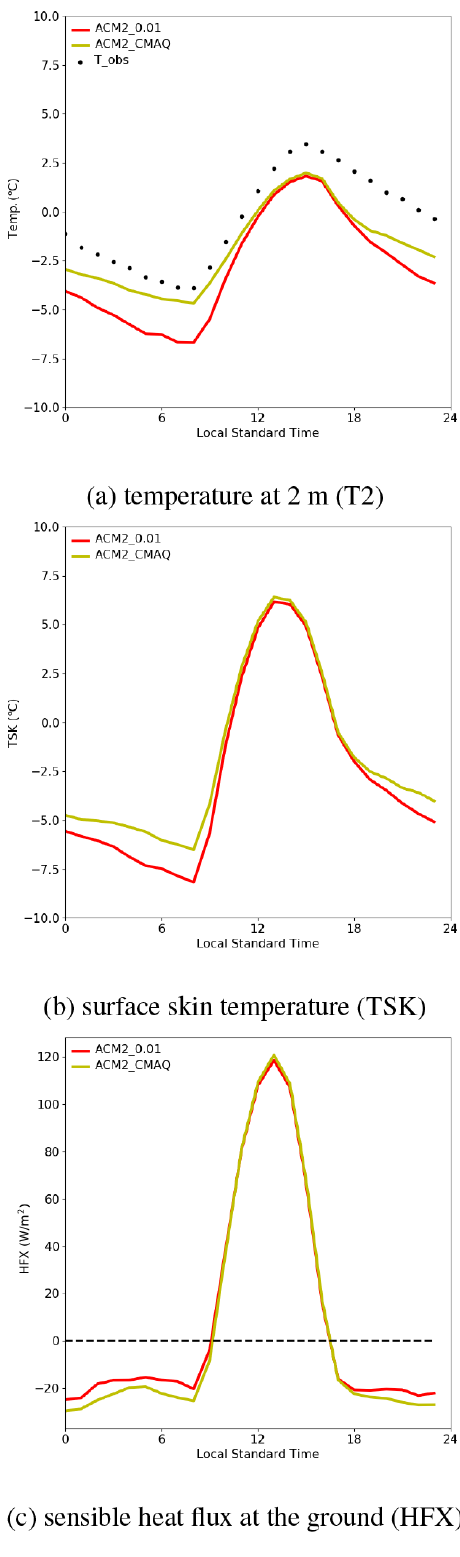
Figure 8. Diurnal mean time series of (a) T2, (b) TSK, and (c) HFX predicted by ACM2_CMAQ and